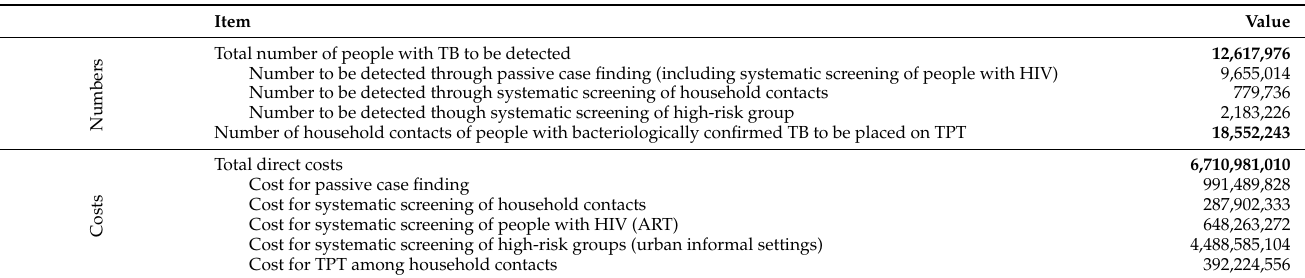
Table 6. Numbers of people with TB to be detected with different approaches and TB preventive treatments to be provided in order to achieve the UNHLM 2018 targets in 33 high-TB burden countries, with estimates of the direct costs of different